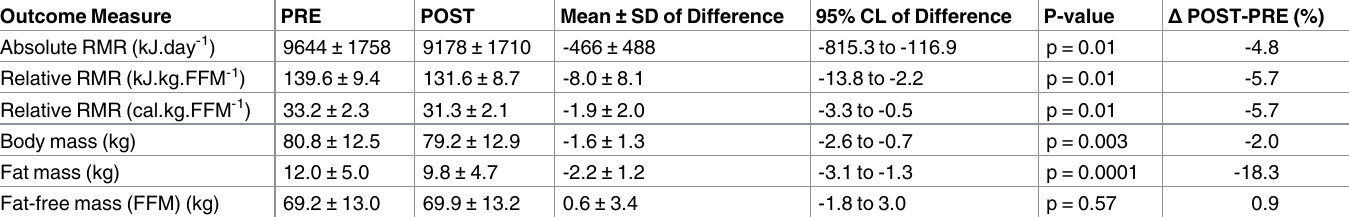
Table 1. RMR and body composition variables PRE and POST the four-week training cycle. Results from paired-samples T-test (POST-PRE) are pre- sented as mean ± SD of difference, 95% CL of difference, and percent change. Outcome